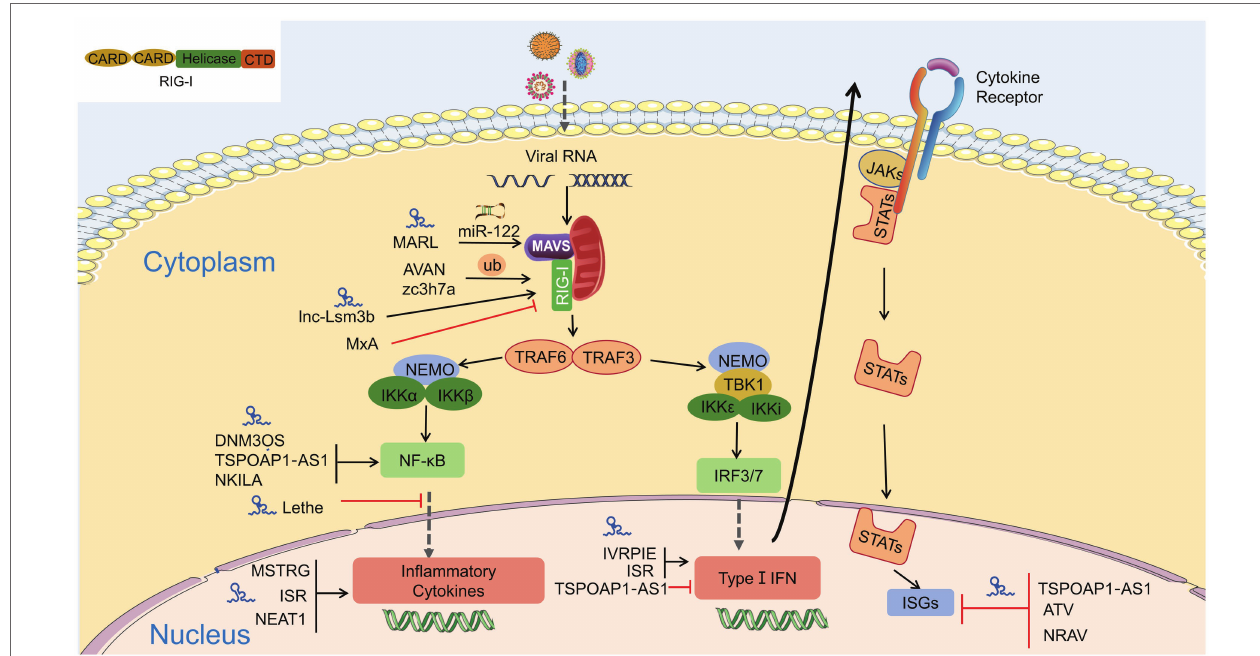
FIGURE 4 | Interaction of lncRNA with RIG-I-MAVS pathway. LncRNAs are regulators in NF- κ B and IRFs via the RIG-I-MAVS pathway and finally modulate IFN/ cytokines. LncRNAs also directly regulate IFNs, cytokines, and even interferon-stimulated genes (ISGs) through Janus Kinases (JAKs)/signal transducer and activator of transcriptions (STATs)